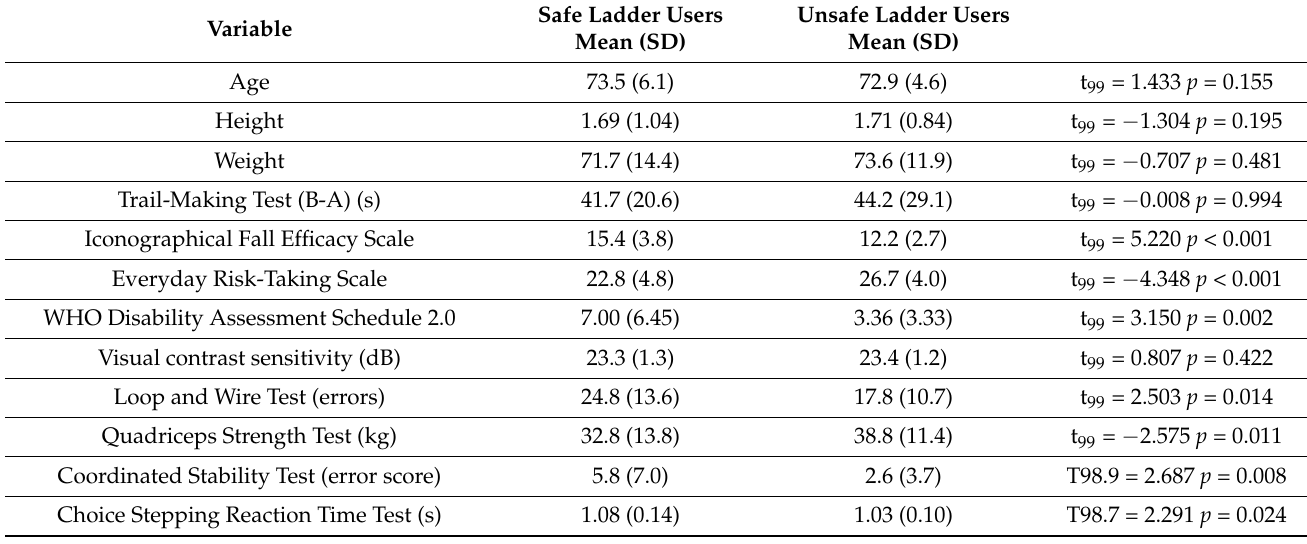
Table 3. Age and anthropometric, executive function, psychological, health/disability, and physical test measures for the safe and unsafe ladder user